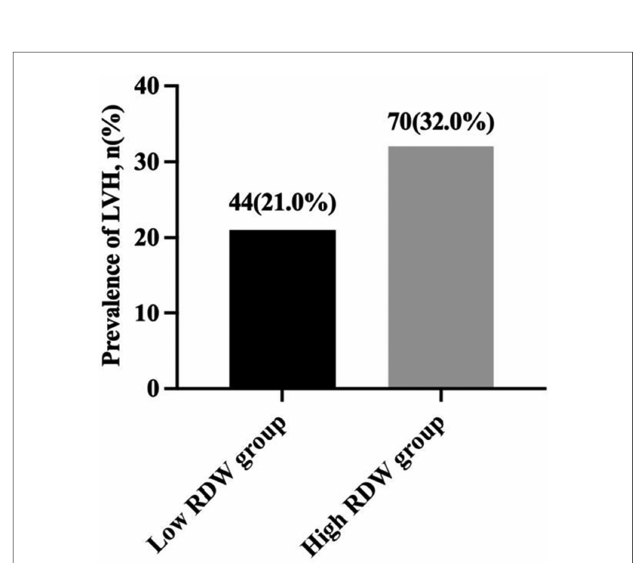
FIGURE 2 Prevalence of LVH in children with essential hypertension according to the dichotomies of RDW. LVH, left ventricular hypertrophy; RDW, red blood cell distribution width.